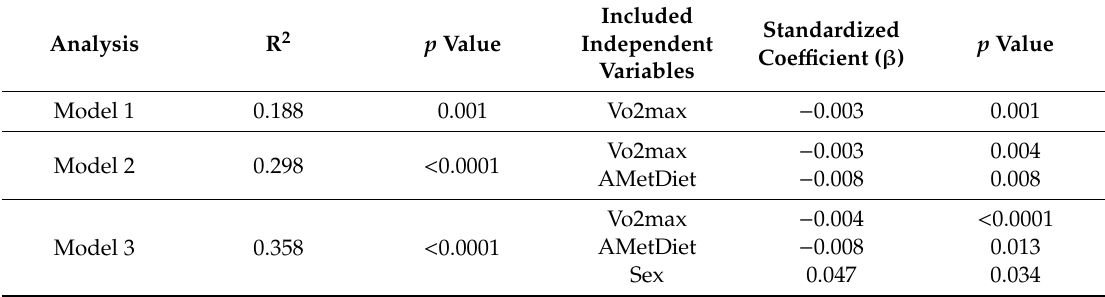
Table 6. Stepwise multiple linear regression analysis of the relationship of systolic blood pressure (SBP) with cardiorespiratory fitness (CRF), Mediterranean diet (AMedDiet), and sex.